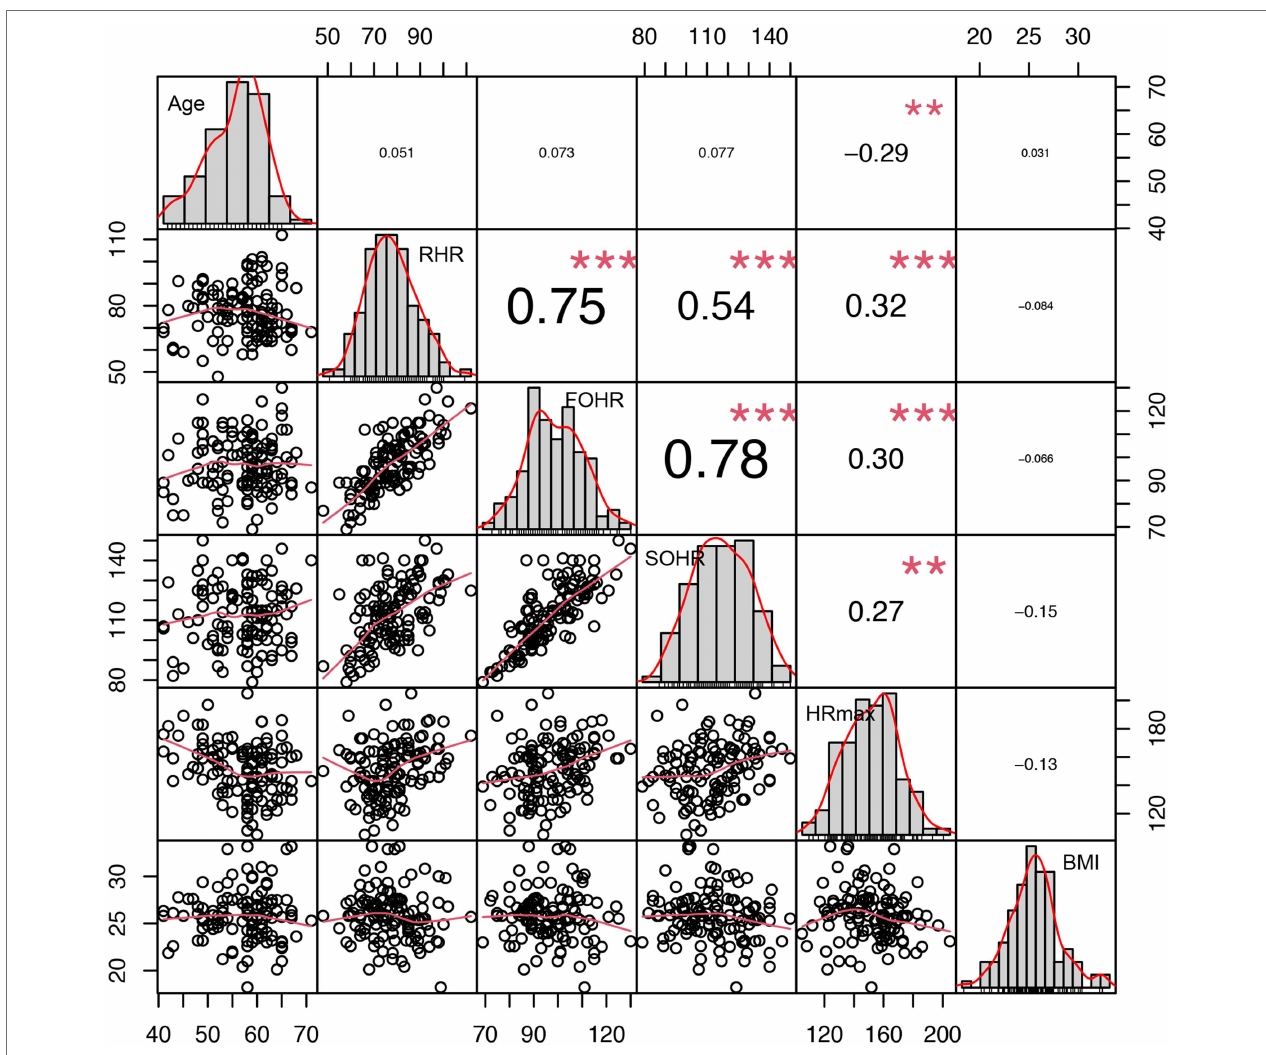
FIGURE 1 | The correlation analysis between the maximal heart rate and other indicators. The scales in x -axis and y -axis are symmetric and indicate the values corresponding to indicators which align diagonally (units are dependent on indicators). The lower triangular areas display the distributions of indicator values by the scatter plots and fitted curves (solid red line), while the upper triangular areas show correlation coefficients between indicators, with asterisks representing the strengths of correlated relation.